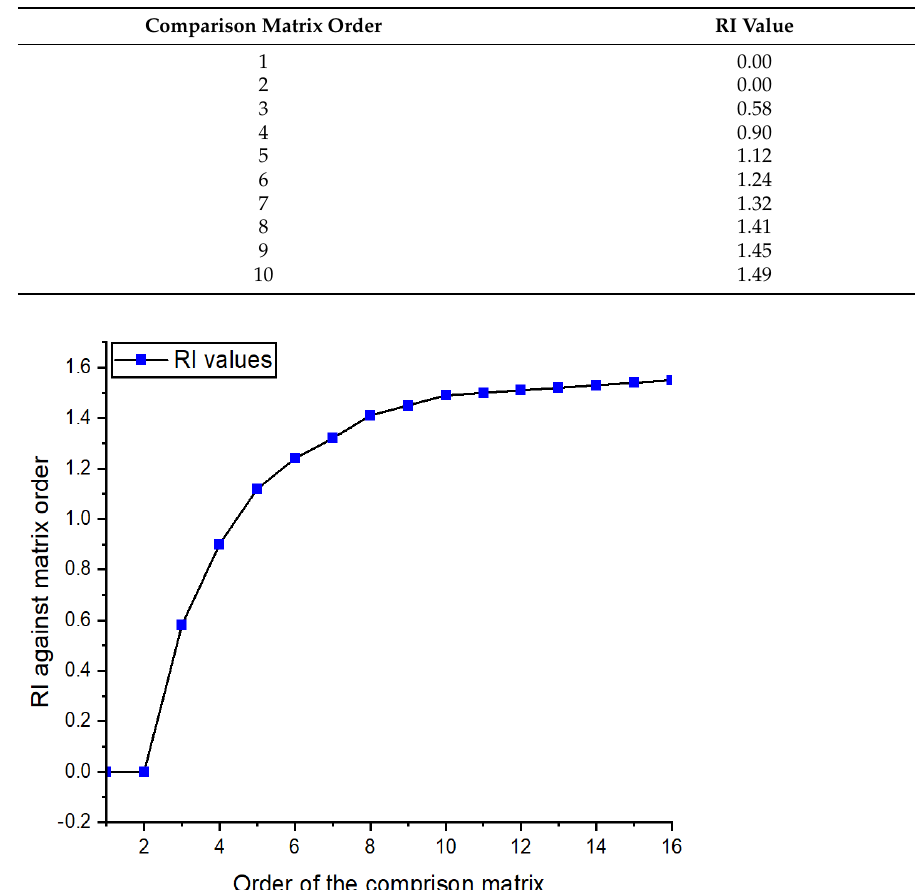
Table 4. Ratio index used for various number of features and controllers [48].